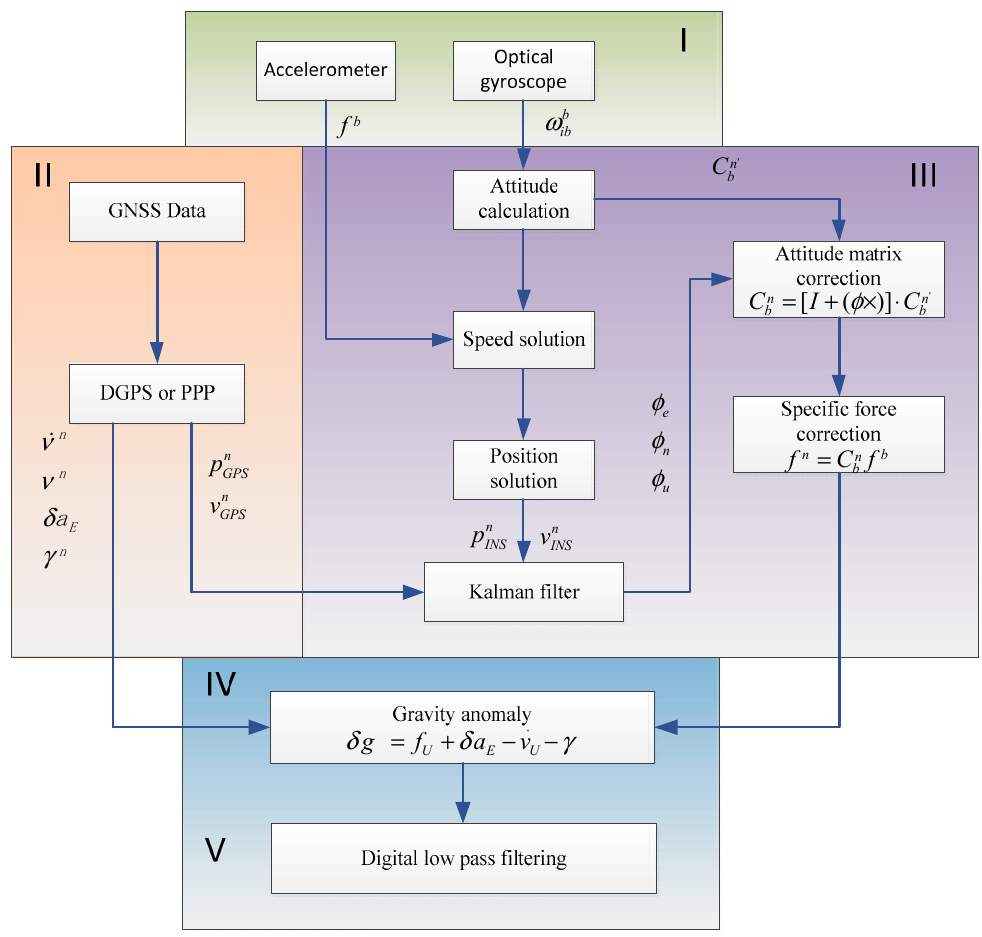
Figure 5. Strapdown gravimeter data processing flow.